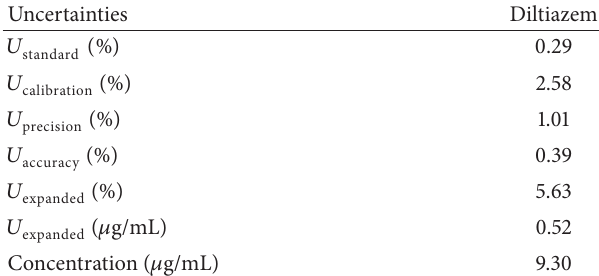
Table 3: Partial and expanded uncertainties associated to the ana- lytical results (expressed as % relative standard